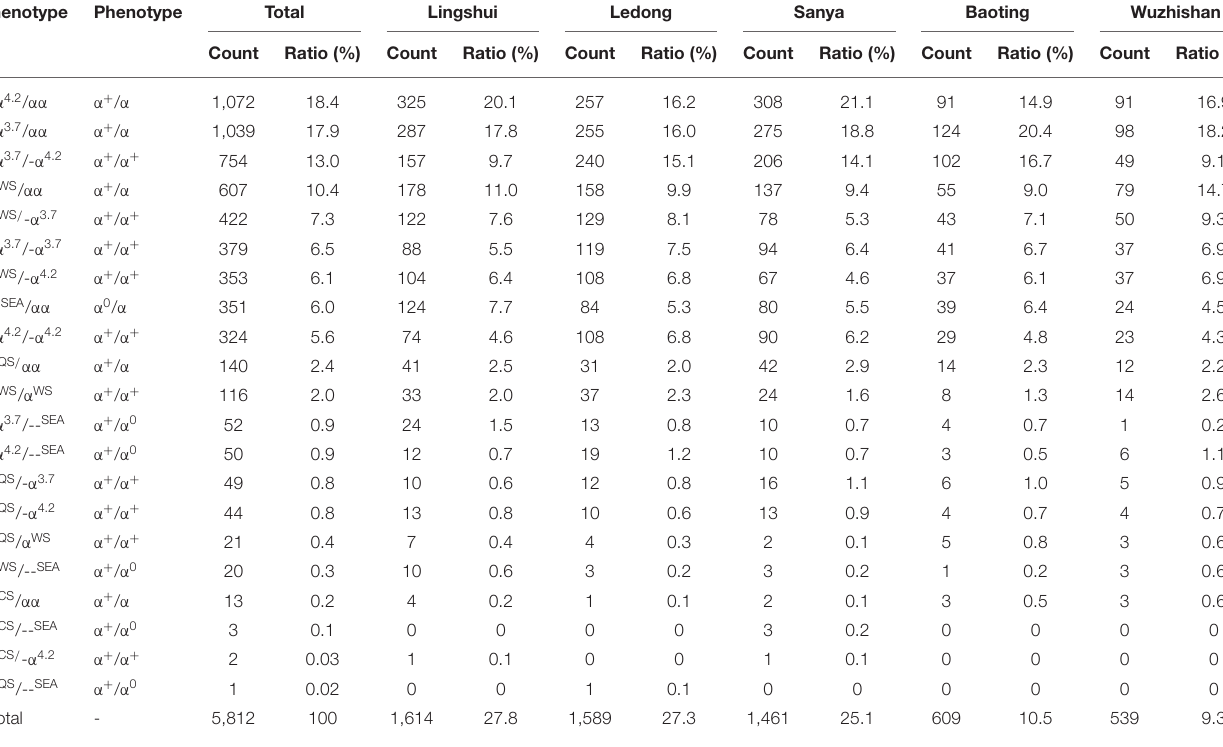
TABLE 1 | Distribution of α -thalassemia genotypes in the southern area of Hainan.